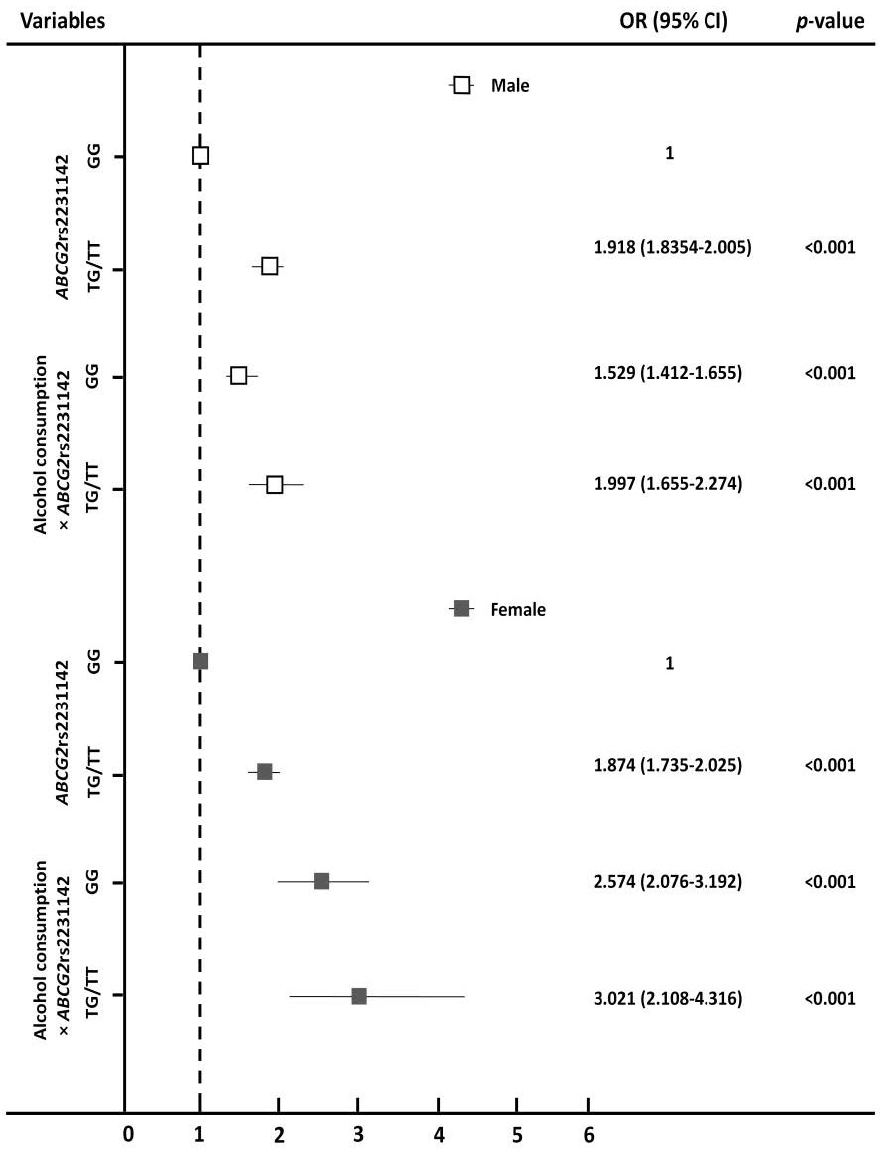
Figure 1. Odds ratios for the association between ABCG2 rs2231142 and alcohol consumption with hyperuricemia. Dotted line represents an OR of 1. Error bars represent the 95% confidence interval of the odds ratios. The p -values were generated using logistic regression.